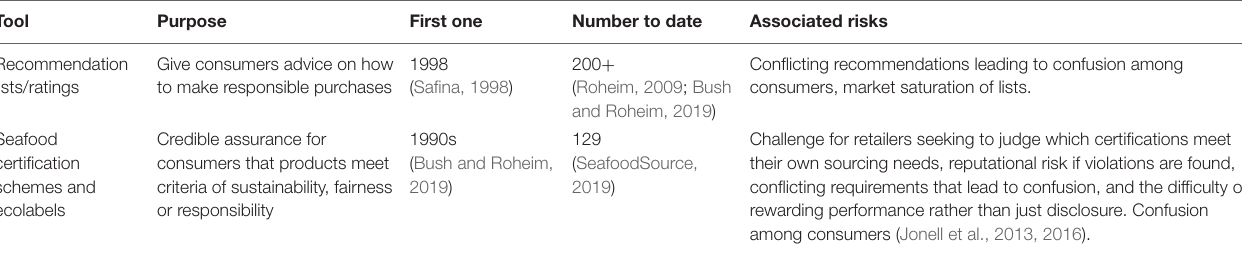
FIGURE 3 | Global production and eco-certifications. Volumes of (A) wild-capture marine fisheries and (B) aquaculture production and corresponding share of MSC-certified and ASC-certified production, respectively. Global production data are from the FAO FishStatJ 4.01.0. MSC- and ASC-certified volumes were provided by MSC and ASC, respectively. TABLE 2 | Proliferation of tools and certification schemes within the sustainable seafood